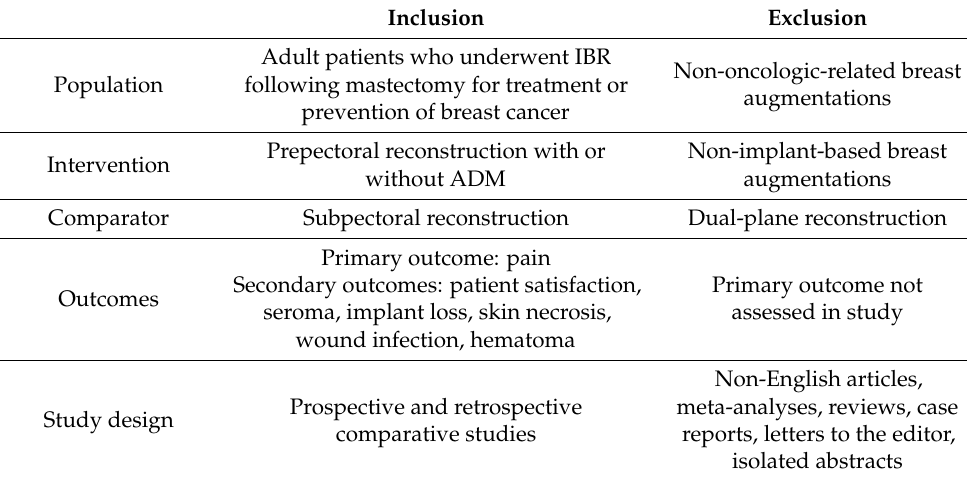
Table 1. PICOS for inclusion and exclusion